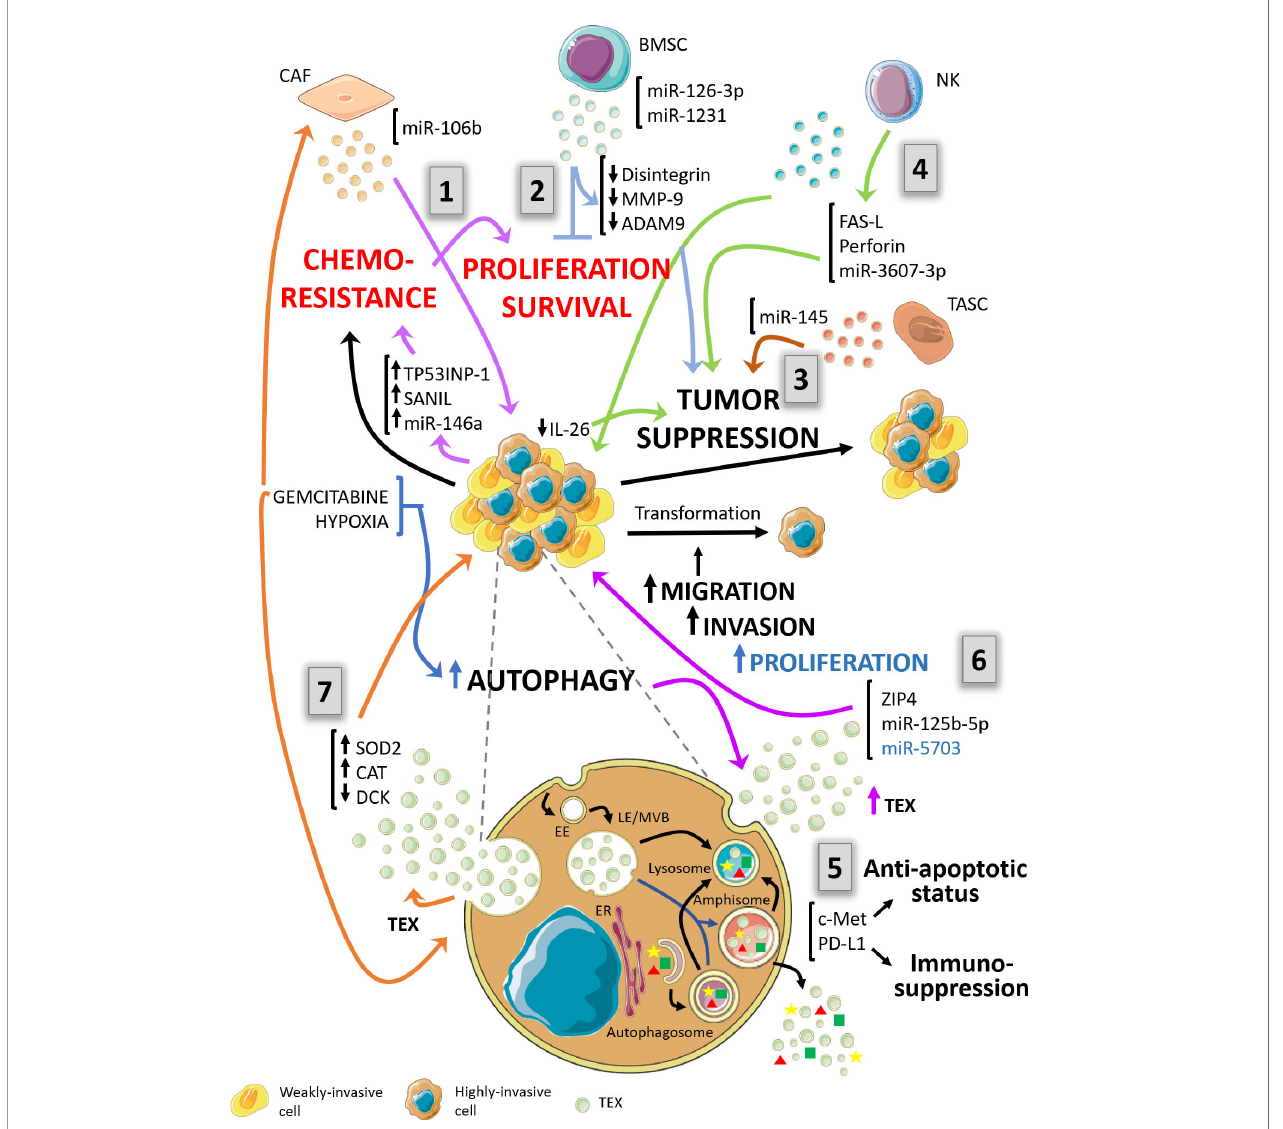
FIGURE 1 | Schematic diagram depicting a proposal model of the complex relationship between autophagy and exosomes in the context of pancreas ductal adenocarcinoma (PDAC) and its environment. The autophagy pathway and exosomes biogenesis are suggested to be highly interconnected. Both pathways share several structures of the endo-lysosomal system. In the context of PDAC and its tumor microenvironment, autophagy and exosomal processes are mutually in fl uenced and condition tumor behavior responding to the pressure of the immune system. (1) – violet arrows - Cancer-associated fi broblasts (CAFs) foster proliferation and chemoresistance. Exosomes bearing miR-106b are released by gemcitabine-treated CAFs increasing proliferation and survival of PDAC cell lines. The effector response is traduced in cancer cells as induction of chemoresistance-inducing factors, Snail, and miR-146a, and TP53INP1. (2) – light blue arrows - Bone marrow mesenchymal stem cell (BMSC)-derived exosomes contain miR-126-3p and miR-1231, which in turn inhibit proliferation, invasion and metastasis and promotes apoptosis by down-regulation of disintegrin and metalloproteinase-9 (ADAM9). (3) – brown arrows - Vesicles from tumor-associated stroma cells (TASC) are enriched in miR-145. This molecule possesses tumor suppressor action on target cells by inducing apoptosis. (4) – green arrows - NK-derived exosomes mediate tumor cells suppression by two mechanisms. One of them is Fas-FasL interaction between exosomes and tumoral cells. The other mechanism is mediated by excessive uptake by cancer cells of exosomes carrying miR-3607-3p which possess tumor suppressive qualities and decrease IL-26 expression. (5) – purple arrows – PDAC tumor exosomes (TEXs) bearing c-Met and PD-L1 enhance carcinogenesis. c-Met provides proliferation, migration, and an anti-apoptotic status in recipient cancer cells. PD-L1 guarantees evasion of immune control. (6) – black arrow – TEXs from highly invasive cells carry ZIP4, miR-125b-5p and miR-5703 towards weakly invasive cancer cells enhancing the aggressiveness of these last and promoting an increased invasive potential. (7) – orange arrows – In response to gemcitabine treatment, chemoresistant PDAC cancer cells are capable of transferring their resistance properties to neighboring cells through exosomes. They release TEXs bearing miR-155 and induce upregulation of SOD2 and CAT meanwhile DCK, a gene related to gemcitabine metabolism, is downregulated. Furthermore, exosomes from different cell types of tumor microenvironment condition autophagy response and affect PDAC behavior. EE, Early endosomes; LE/MVB, Late Endosomes/Multivesicular bodies; ER, endoplasmic reticulum; TEX, Tumor-derived